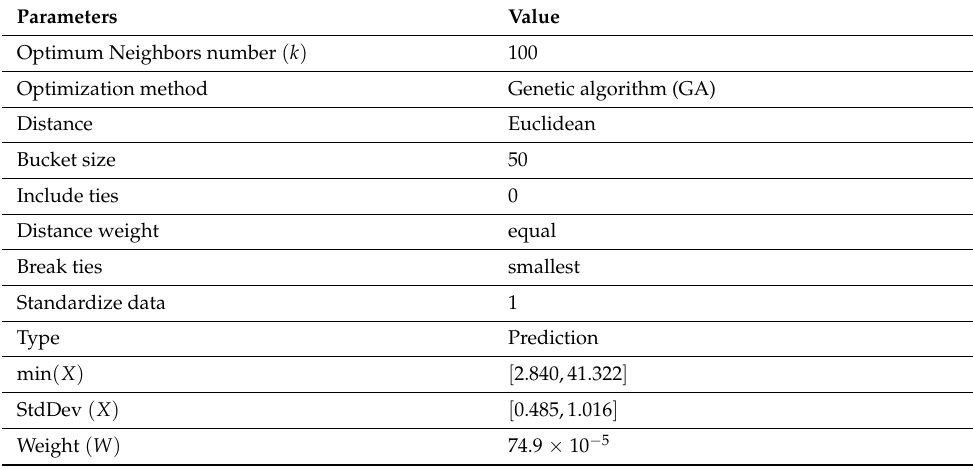
Table 4. k-NN internal